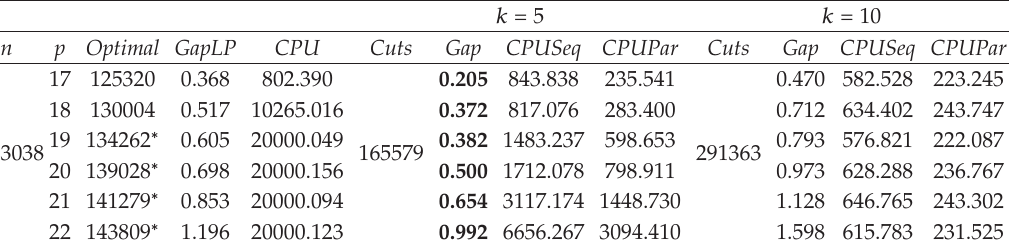
Table 3: Computation times for TSPLIB PCB3038 instance, U (cid:6)